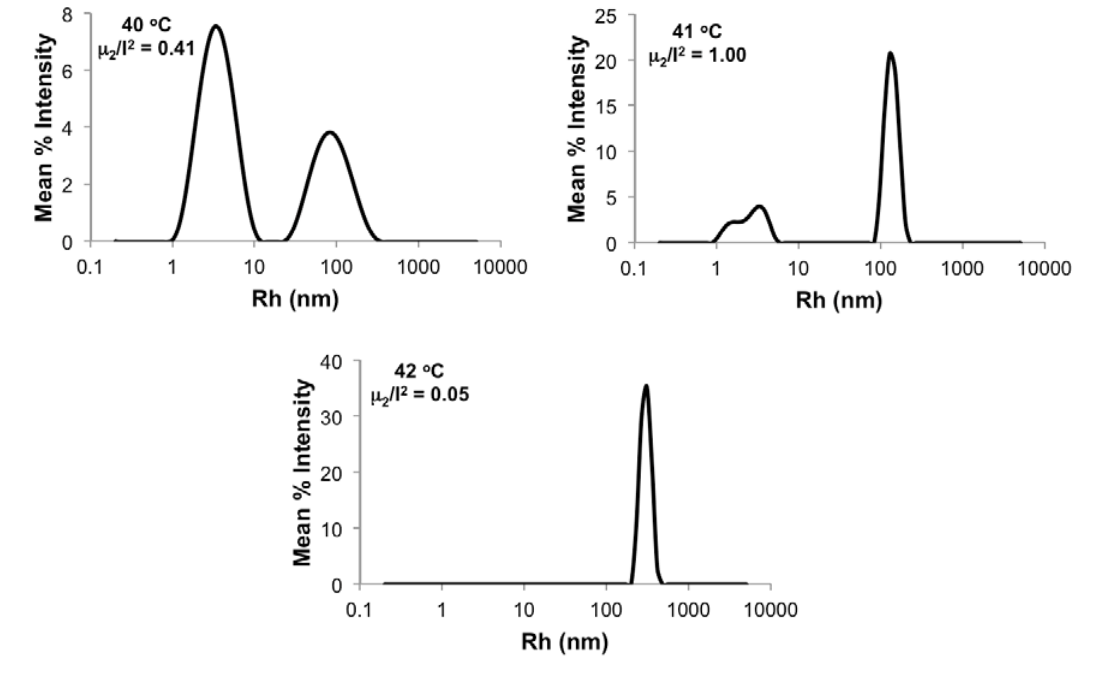
Figure 6. Hydrodynamic radius distribution (using mean % intensity) for 0.3 wt% solution of poly(DMAEMA- stat -styrene) with F = 96 mol% (DMAEMA/S-95/5) at 40–42 DMAEMA